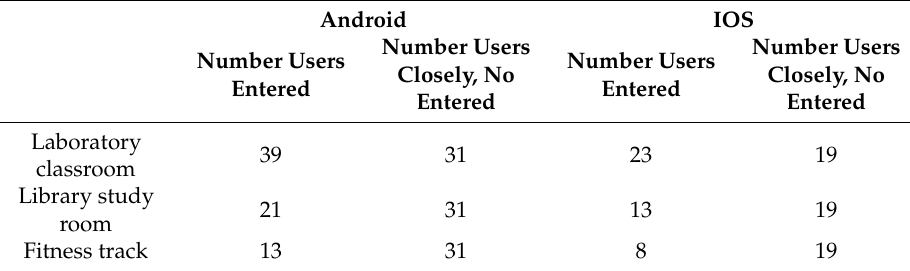
Table 3. Detail about number of users participated in tests.